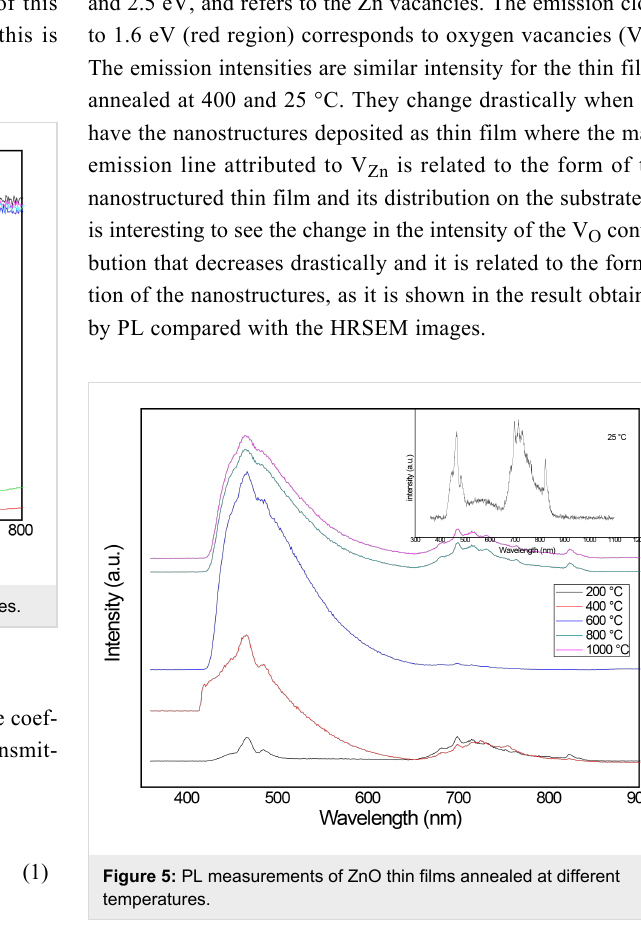
Estimation of the optical band gap